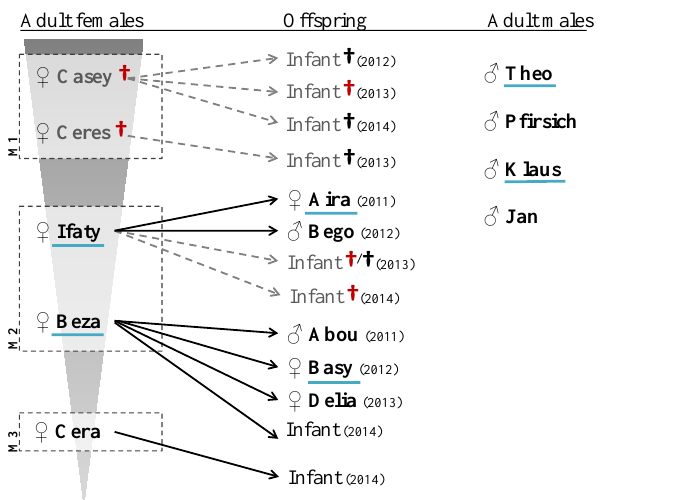
Figure 1. Composition of group A in spring 2014 and the relation- ships between the individuals; M: matriline; grey triangle: female ♀ Casey † was killed by a rank order, from highest to lowest;